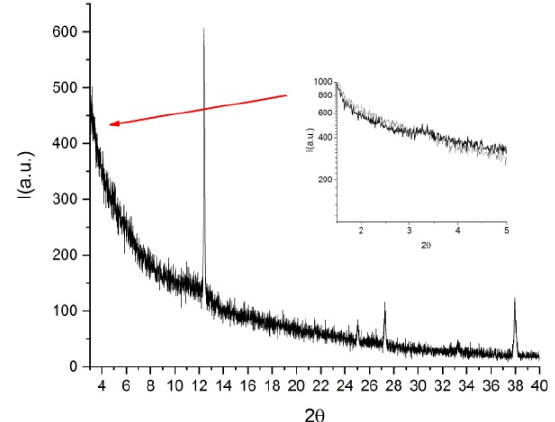
Figure 7. X-ray diffractogram of DSCG doped with Trans-Hyp.